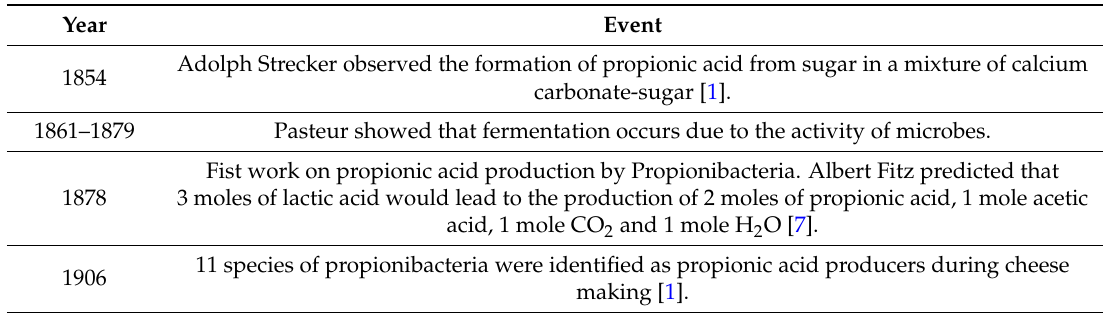
Table 1. Overall historical development of the propionic acid fermentation